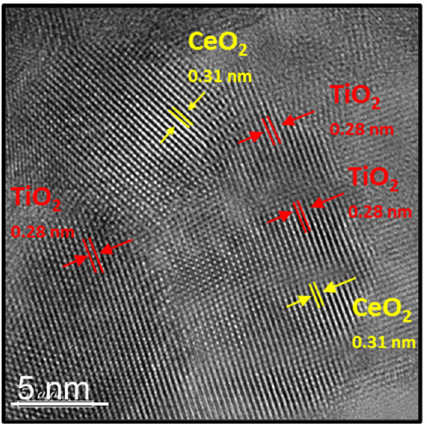
Figure 2. HRTEM(HighResolutionTransmissionElectronMicroscopy)imageofthebrookiteTi / Ce5sample. Figure 2. HRTEM (High Resolution Transmission Electron Microscopy) image of the brookite Ti/Ce5 sample.